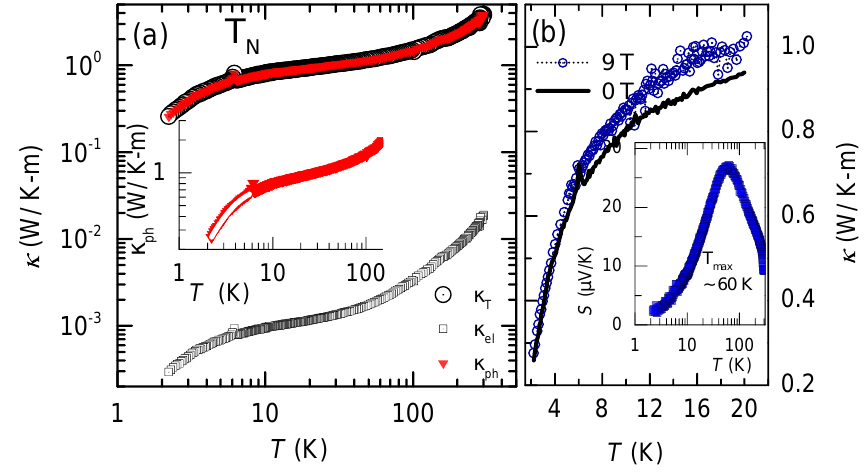
Figure 5. ( a ) The total thermal conductivity, κ T ( T ) , separated in to electronic ( κ el ) and lattice ( κ ph ) contributions. The magnetic phase transition at T N is seen in κ ( T ) also. The inset shows the κ ph along with a curve-fit to the region below the T N as κ ( T ) ∝ T . ( b ) The κ T ( T ) in 0 T and 9 T. Only a slight change in κ T ( T ) is effected with the application of 9 T, that too above the T N . The Seebeck coefficient, S is plotted in the inset of ( b